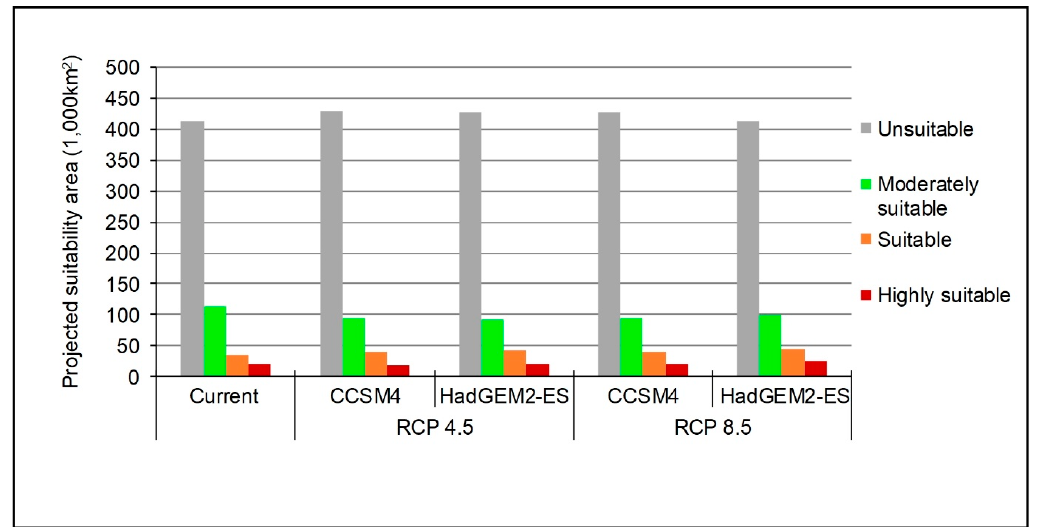
Figure 7. Current and future potential area suitability for maize growing in Kenya under RCP 4.5 and RCP 8.5 for the year 2070.